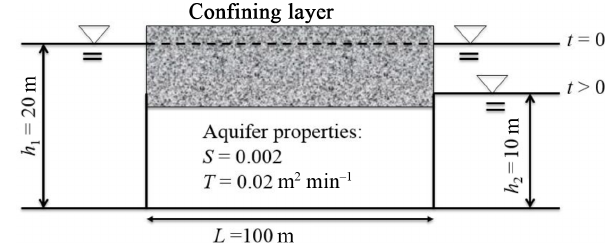
Figure 2. The reservoir example modified based on Wang and An- derson (1995).